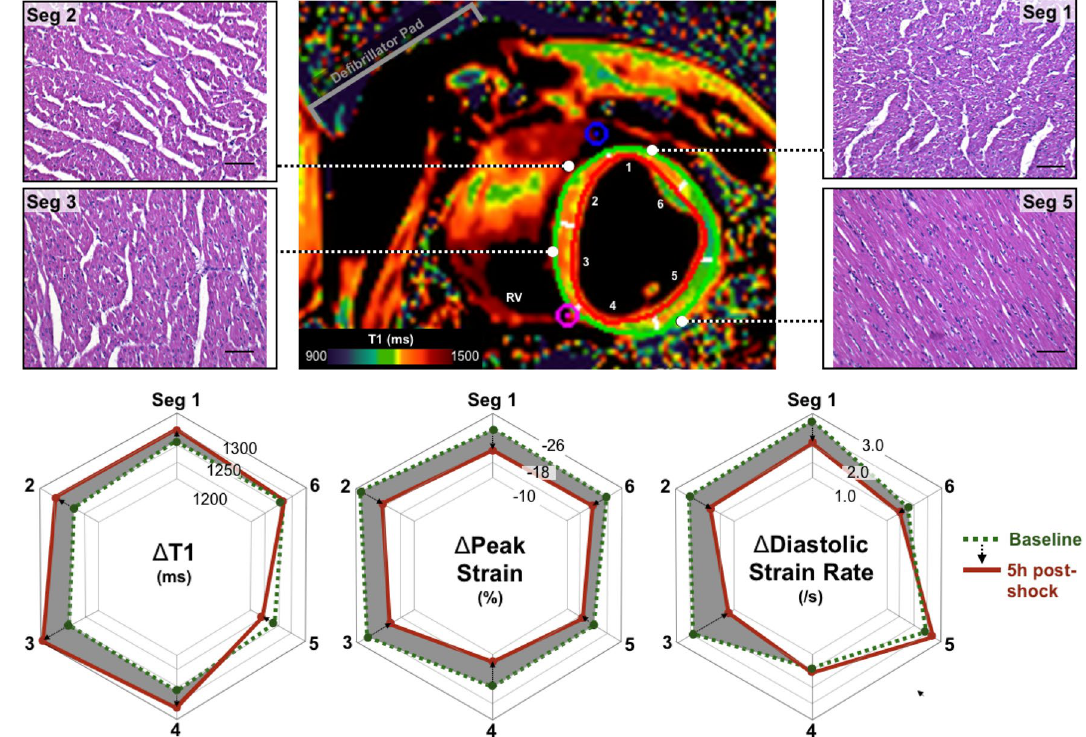
Figure 3. Regional impact of electrical interventions on the LV. For the respective slice, the T1 map acquired at 5 h post electrical intervention depicts higher signal (orange) in the septum indicating myocardial injury. This matches the histological samples in which interstitial space is greatest in sample acquired from the septum in comparison to the lateral wall. The polar plots on the bottom row depict the quantitative measurements for each of the six segments in the slice at baseline (green) and 5 h post intervention (red), with the change between timepoints shaded in grey.